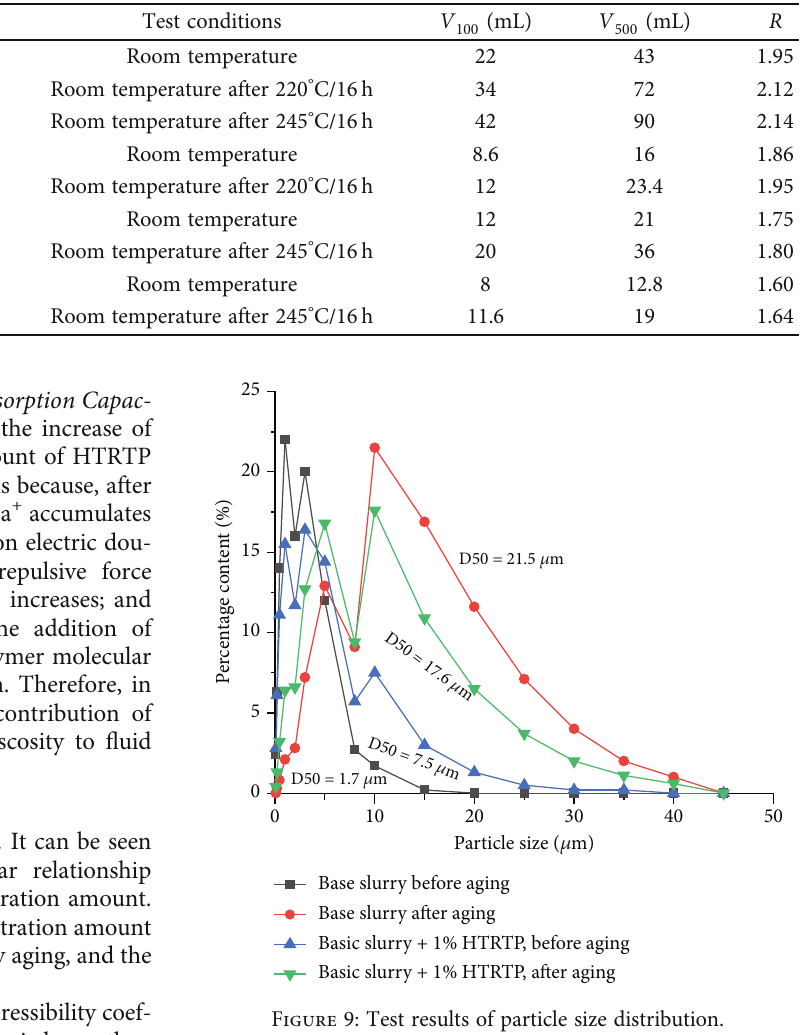
Table 8: Test results of fi lter cake compressibility.